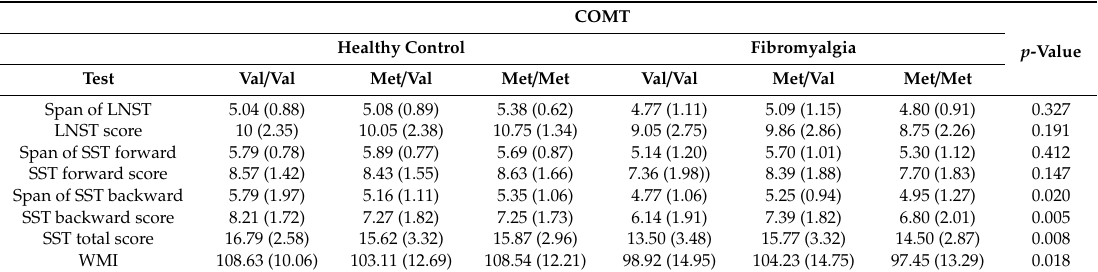
Table 3. Mean scores and standard deviations (in parenthesis) for working memory measures. Data are separated by group (fibromyalgia and HC) and genotype (Val / Val, Met / Val and Met / Met). p -values for the interaction between the COMT genotypes and group are also included.